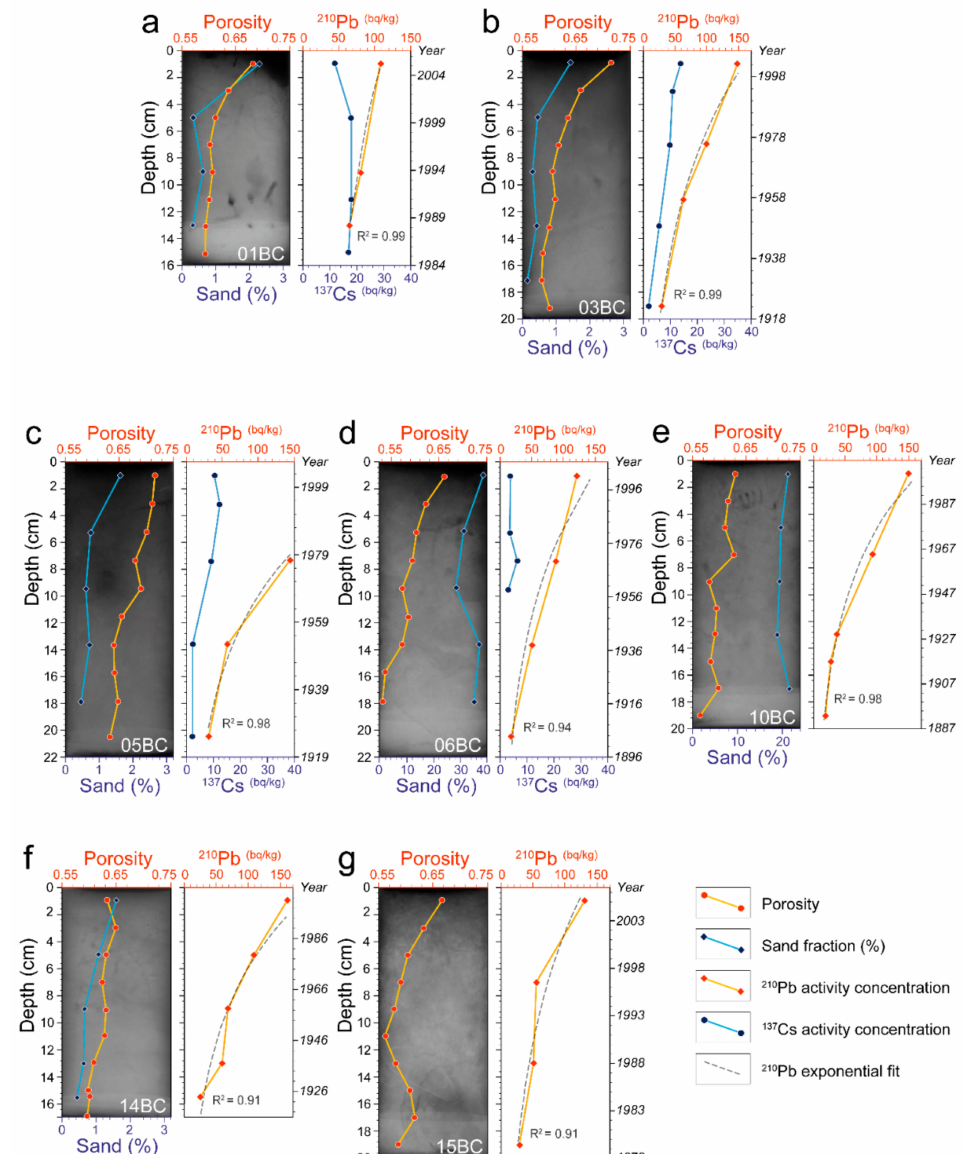
Figure 3. Examples of X-ray images, porosity and sand content depth profiles (left panel), and 210 Pb and 137 Cs concentration activity variations with depth (right panel) from selected box cores (BCs): ( a ) 01BC; ( b ) 03BC; ( c ) 05BC; ( d ) 06BC; ( e ) 10BC; ( f ) 14BC and ( g )